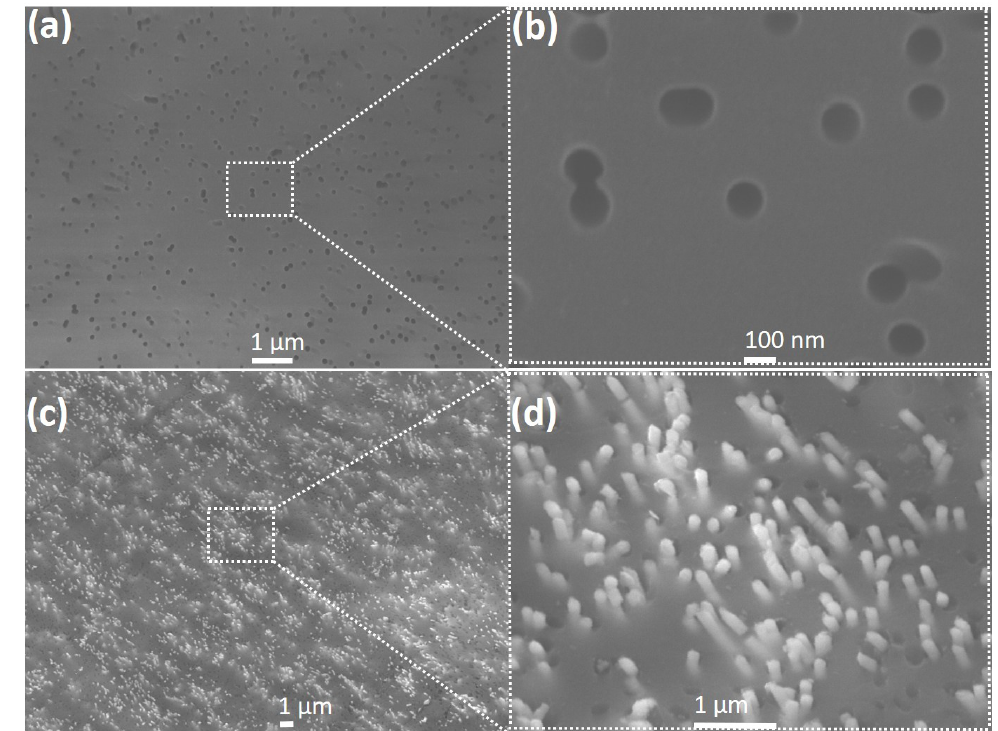
Figure 3. SEM images of blank polycarbonate membrane before and after growth of InSb nanowires ( a ) SEM image of bare polycarbonate template; ( b ) zoomed in SEM image of polycarbonate template with different diameters and shape of pores, ranging from 150 – 200 nm; ( c ) SEM image of InSb NW ∼ exposed tips after 30 s of oxygen plasma etching; and ( d ) zoomed in SEM image of exposed tips of InSb